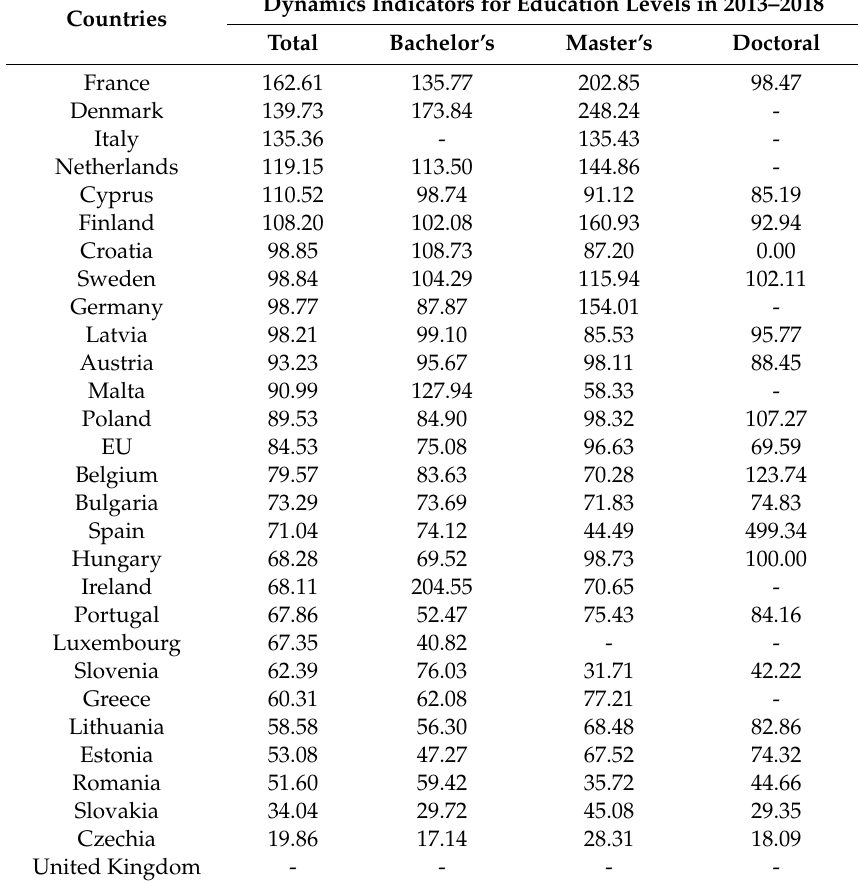
Table 2. Dynamics indicators for the number of students studying electricity and energy in EU countries in 2013–2018 (year 2013 =